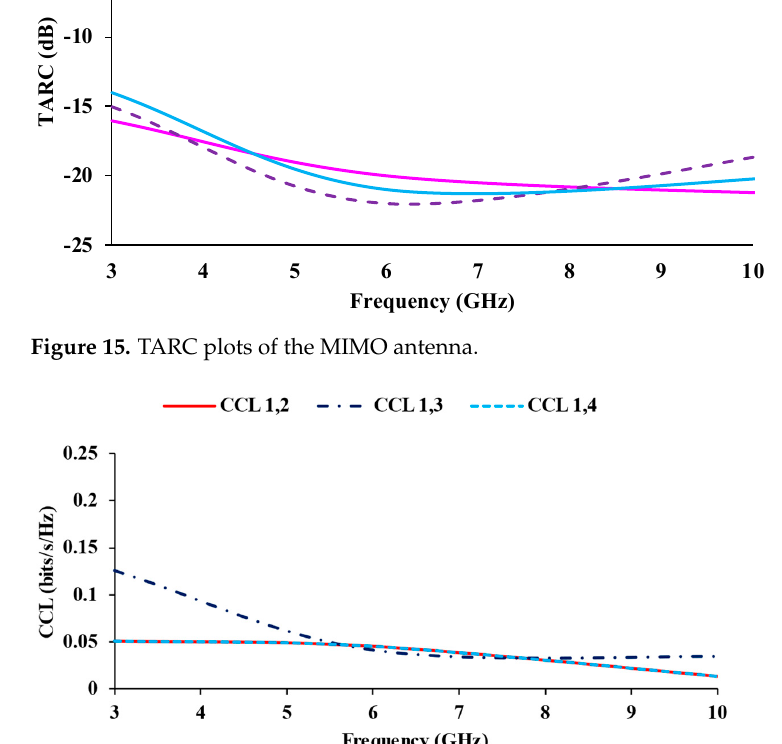
( c ) Figure 17. Bending analysis of the antenna at three bending radii ( a ) BR = 25 mm, ( b ) BR = 20 mm, ( c ) BR = 15 mm.